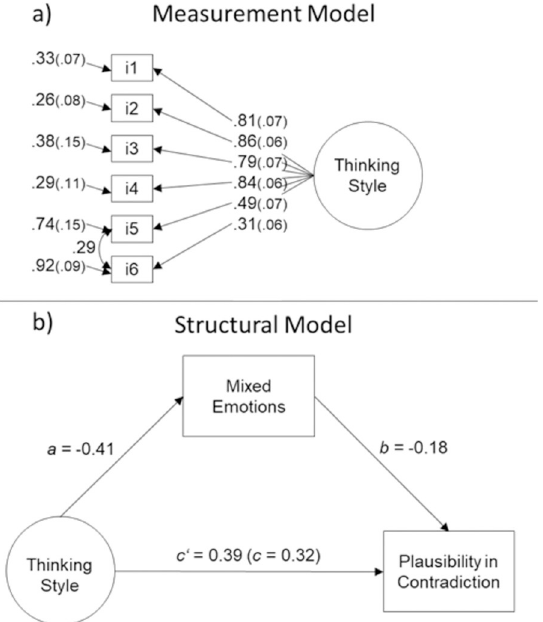
Fig 2. (a) top panel: Item factor loadings, Study 2; (b) bottom panel: Final structural equation model; standardized path coefficients are presented, Study 2. � p < 0.001. Total effect and direct effect (in brackets) are